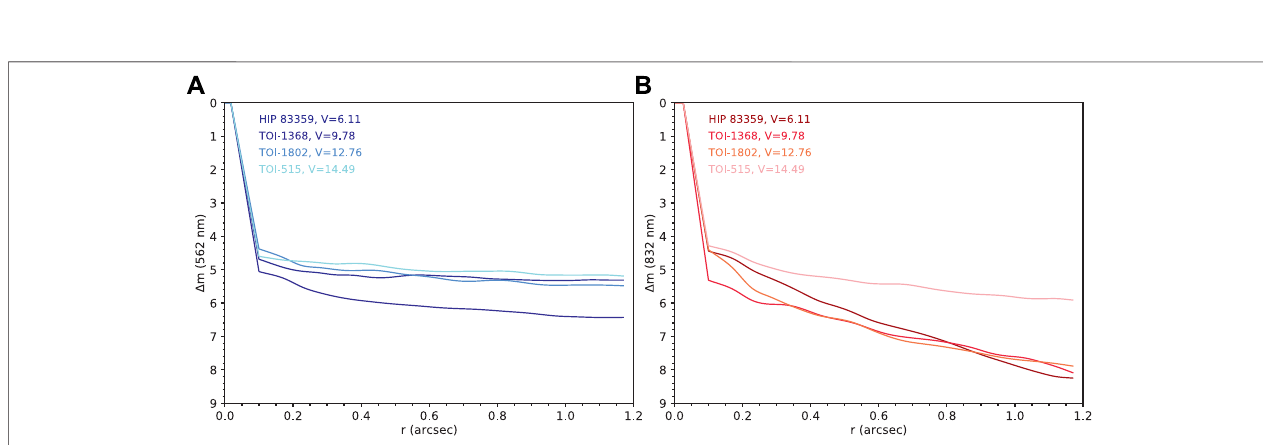
FIGURE 2 | Representative speckle image contrast curves for a selection of stars observed with the Gemini North telescope using ‘ Alopeke during semester 2020A.Thecurvesshowthe5 σ contrastlevelswereachedineachcaseat562 nm (A) and832 nm (B) asafunctionofprojecteddistancefromthestar.NotethattheV= 9.8 targetwasobservedingoodseeing conditions(0.7 ″ )at anairmassof1.1whiletheV=6.1target wasobservedat anairmassof1.7inpoorseeing conditions(1.2 ″ ). Contrastcurvessuchastheseareproducedforeveryobservation,andthevaluesusedin Figures3 – 9 givethemeasuredcontrastlevelatangulardistancesof0.2, 0.5, and 1.0 ″ for each